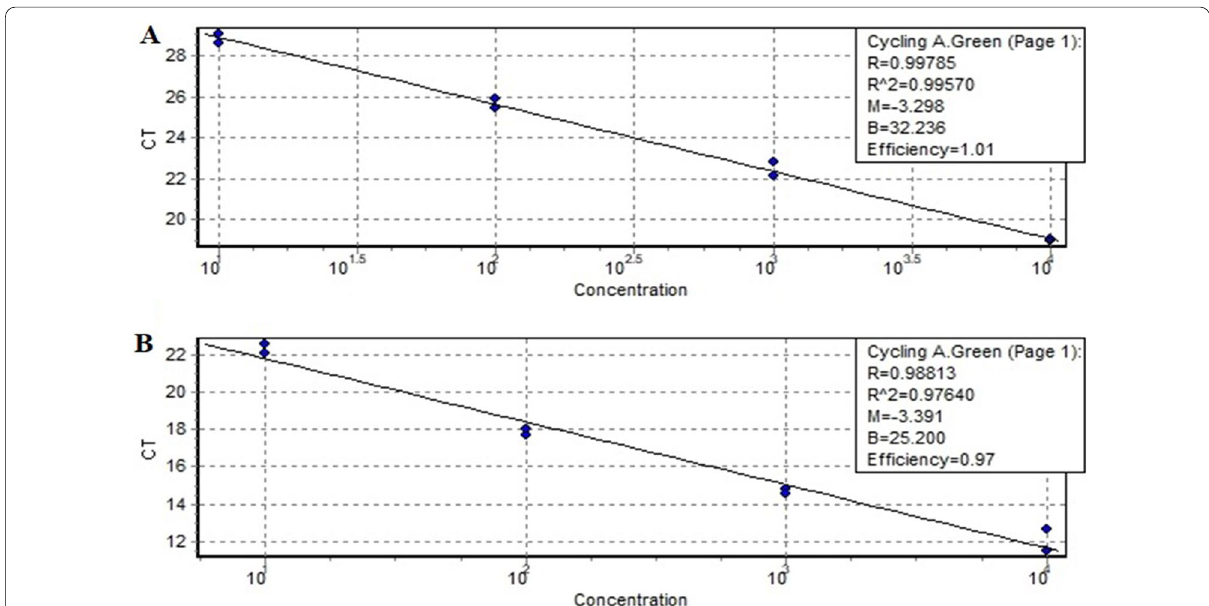
Fig. 1 PCR efficiency of qPCR primers drawn by standard curve assay. A The efficiency of β‑actin primer was 101%. B The efficiency of TNF‑α primer was 97%. PCR efficiency of TaqMan probe and primers is stated with 100%